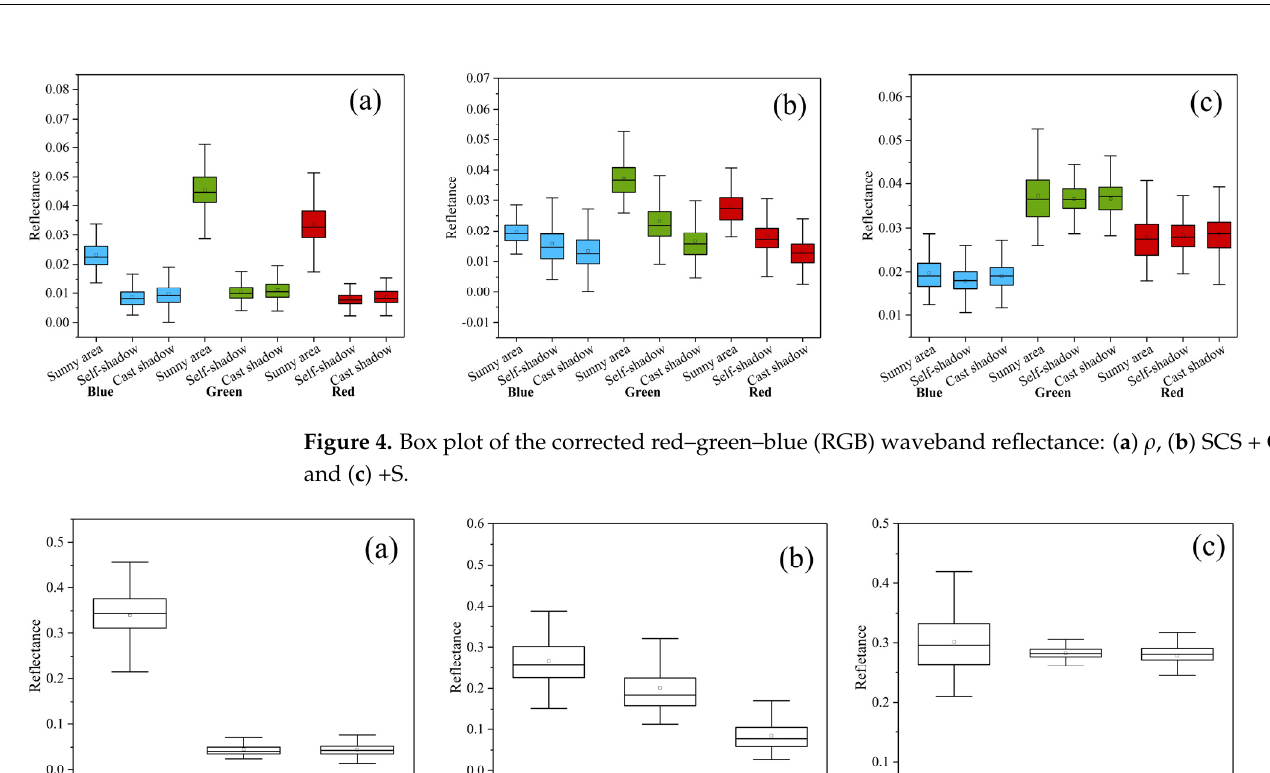
Figure 3. Sample areas of different processed images (NRG composite), cos i , and SEVI: ( a ) surface